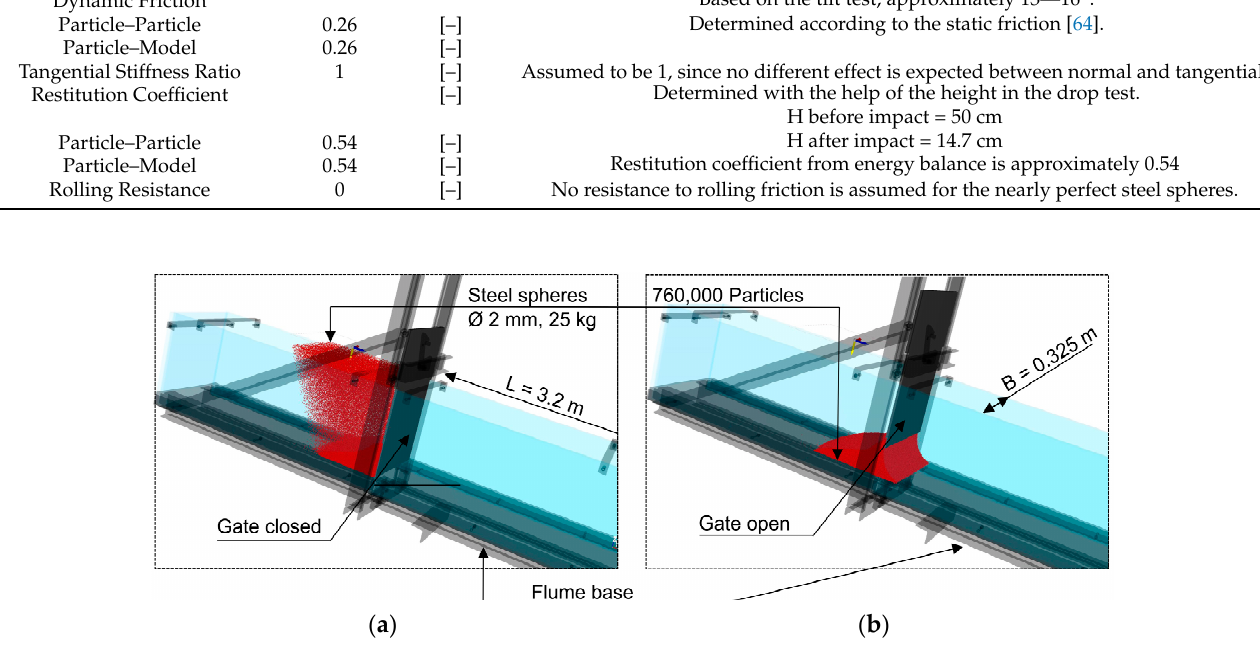
Figure 8. DEM model; the creation of the particles ( a ) and the opening of the gate ( b ). Table 7. Friction and restitution coefficients between the particle and particle model test used for DEM simulation. The column on the right describes the results of the laboratory test for the test material.